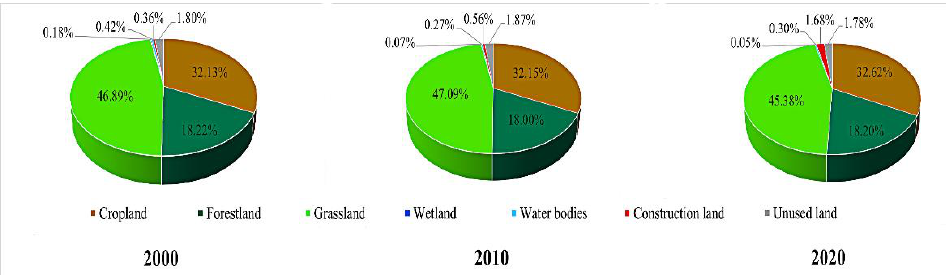
Figure 3. The proportion of different land types in the Loess Plateau of Northern Shaanxi.